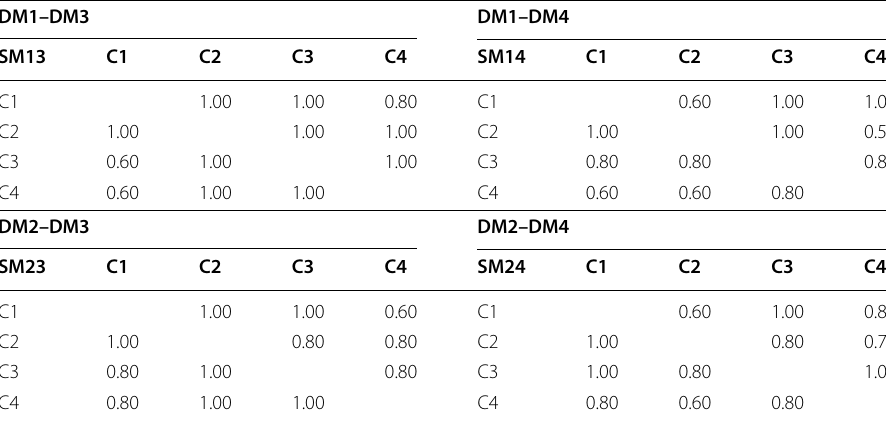
Table 6 Similarity matrices for the equity-based crowdfunding alternative